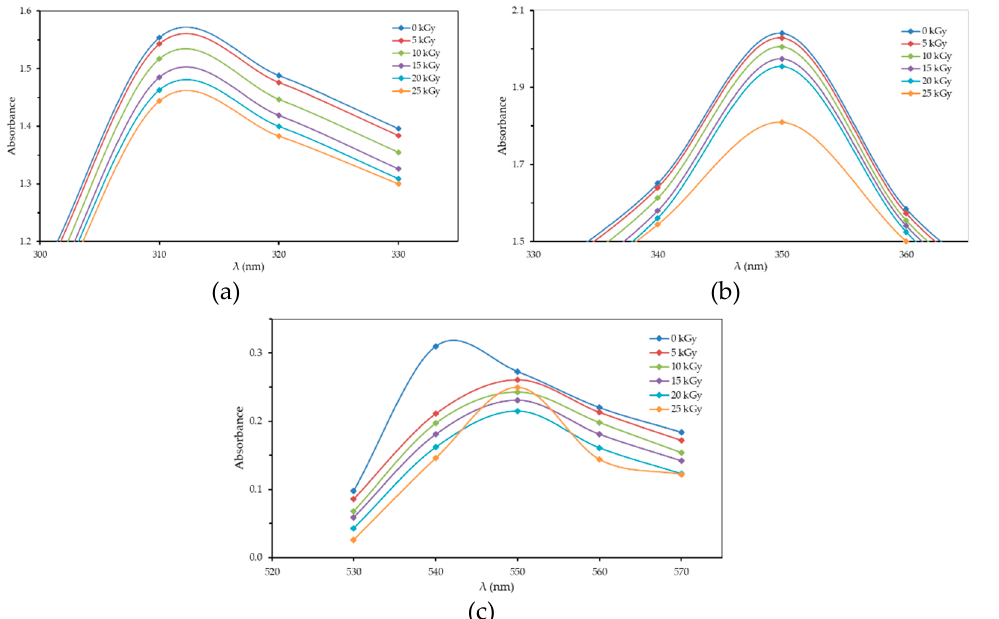
Figure 3. The relationship between absorbance (A) and wavelength ( λ ) for H 3 PO 4 85 v% concentration for each radiation dose: ( a ) λ = 310 nm (peak I); ( b ) λ = 350 nm (peak II); ( c ) λ = 550 nm (peak III).